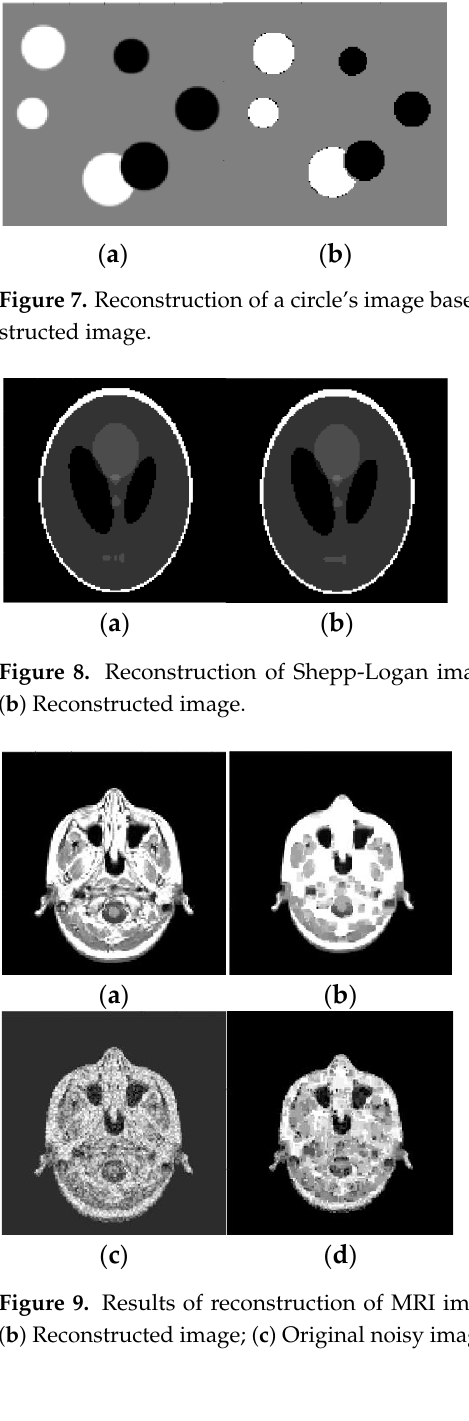
Figure 6. Representation of a numerical line as a chain of intersected spots.